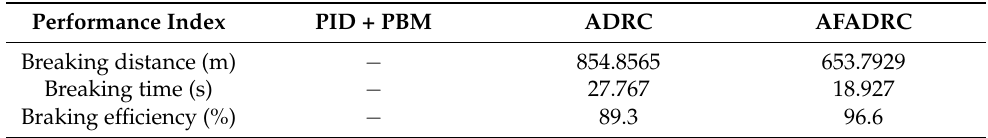
Figure 9. Case 3 simulation results: ( a ) aircraft velocity and wheel velocity; ( b ) breaking distance; ( c ) slip ratio; ( d ) AESO parameters; ( e ) control input; ( f ) extended state. Table 11. AABS performance index in Case 3.